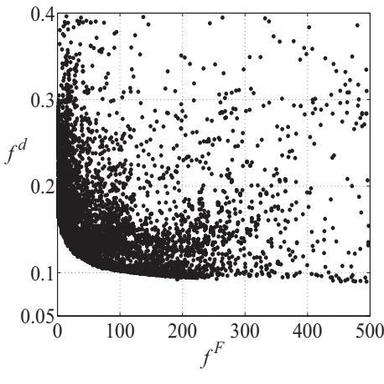
Multi-objective results using MISO5 model.